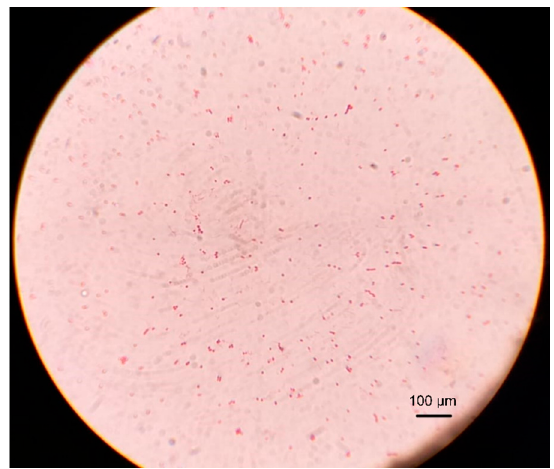
Figure 2. Gram staining of Pseudomonas putida.